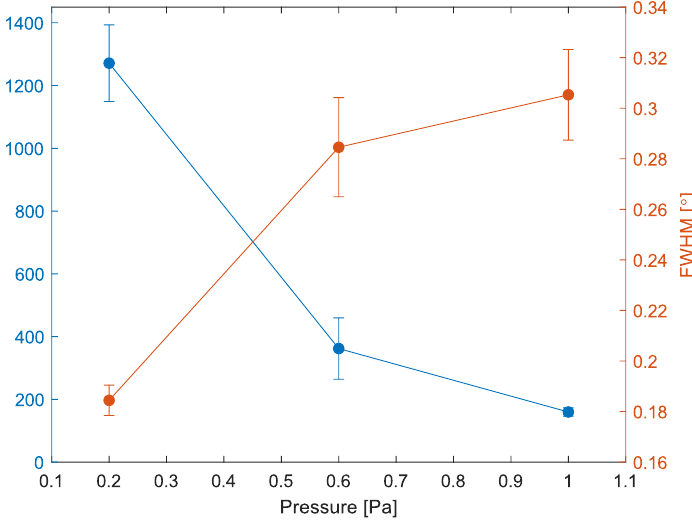
Figure 2. Film stress and FWHM of the AlN(002) peak for films grown using different process- ing